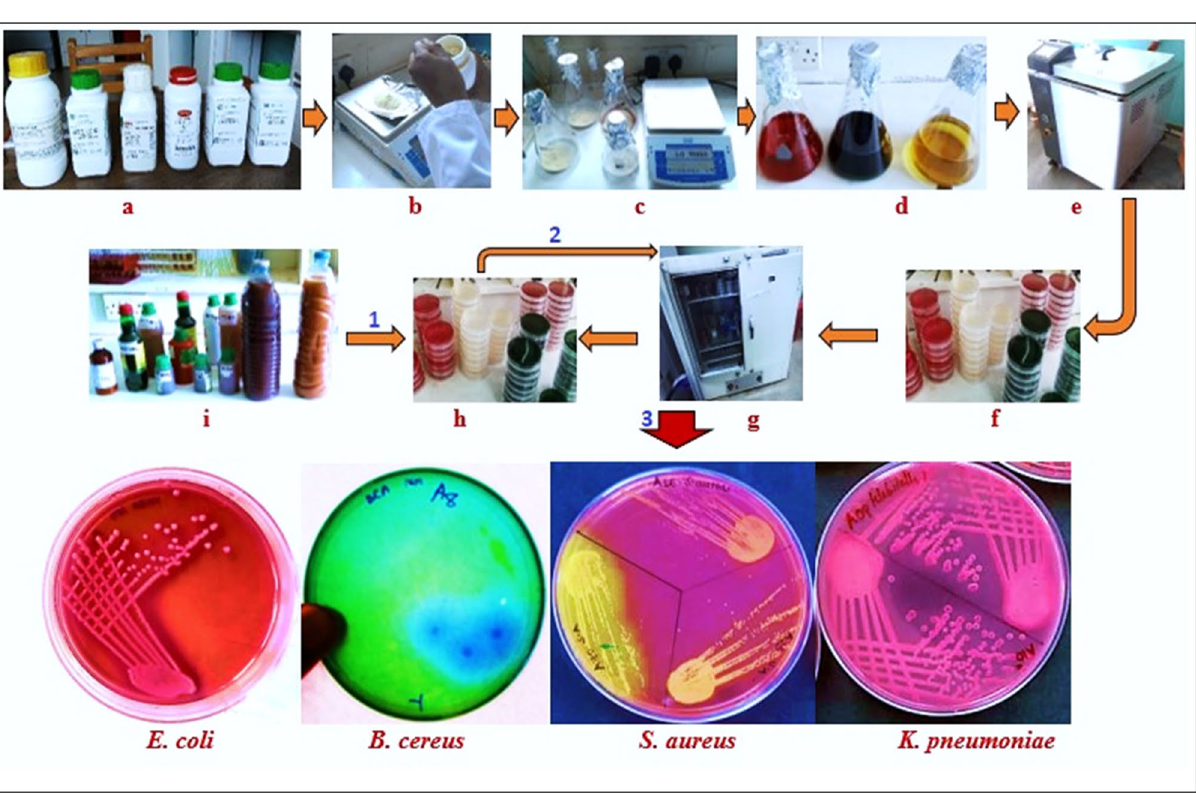
Figure 4. Schematic diagram for isolation of selected bacteria from herbal medicines sold in Kampala city. ( a ) The panel of bacterial culture media used, ( b ) culture media weighed (according to the